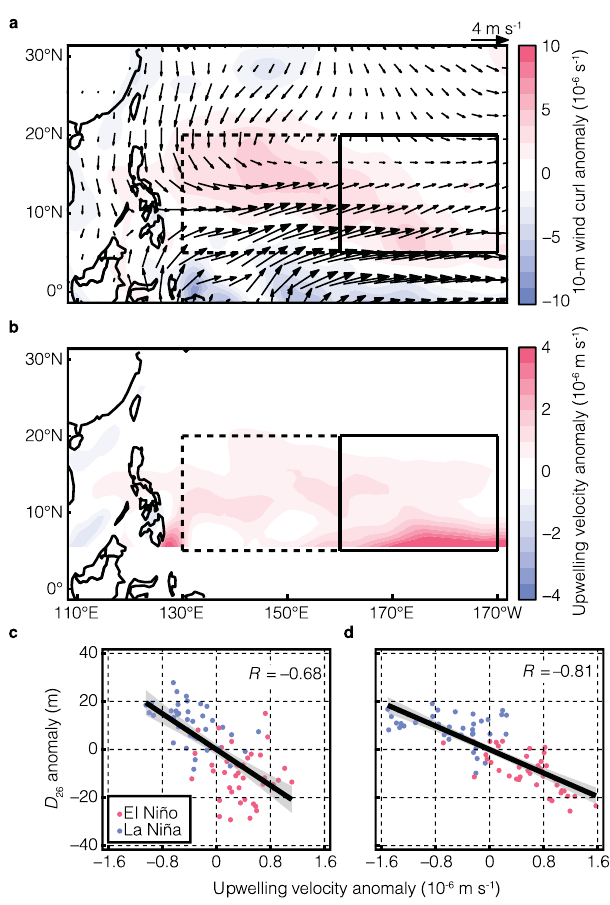
Fig. 5 | Shoaling of the 26°C isotherm depth ( D 26 ) due to surface wind stress curlanomalyanditsEkmaneffect.a Westerlywindanomalies(vector;unit:ms − 1 ) and 10-m wind curl anomalies (color shading; unit: 10 − 6 s − 1 ) during El Niño with respecttoLaNiña. b EkmanupwellingvelocityanomaliesduringElNiño againstLa Niñaand the unitis10 − 6 ms − 1 . c Thescatterplotof regionalmeanEkmanupwelling velocity anomalies and D 26 anomalies in the tropical northwestern Paci fi c. The red (blue) dots are for El Niño (La Niña). d Same as c but for the tropical central-north Paci fi c. Both correlation coef fi cients are statistically signi fi cant at 99% con fi dence level and the 95% con fi dence interval of the trendline is depicted in